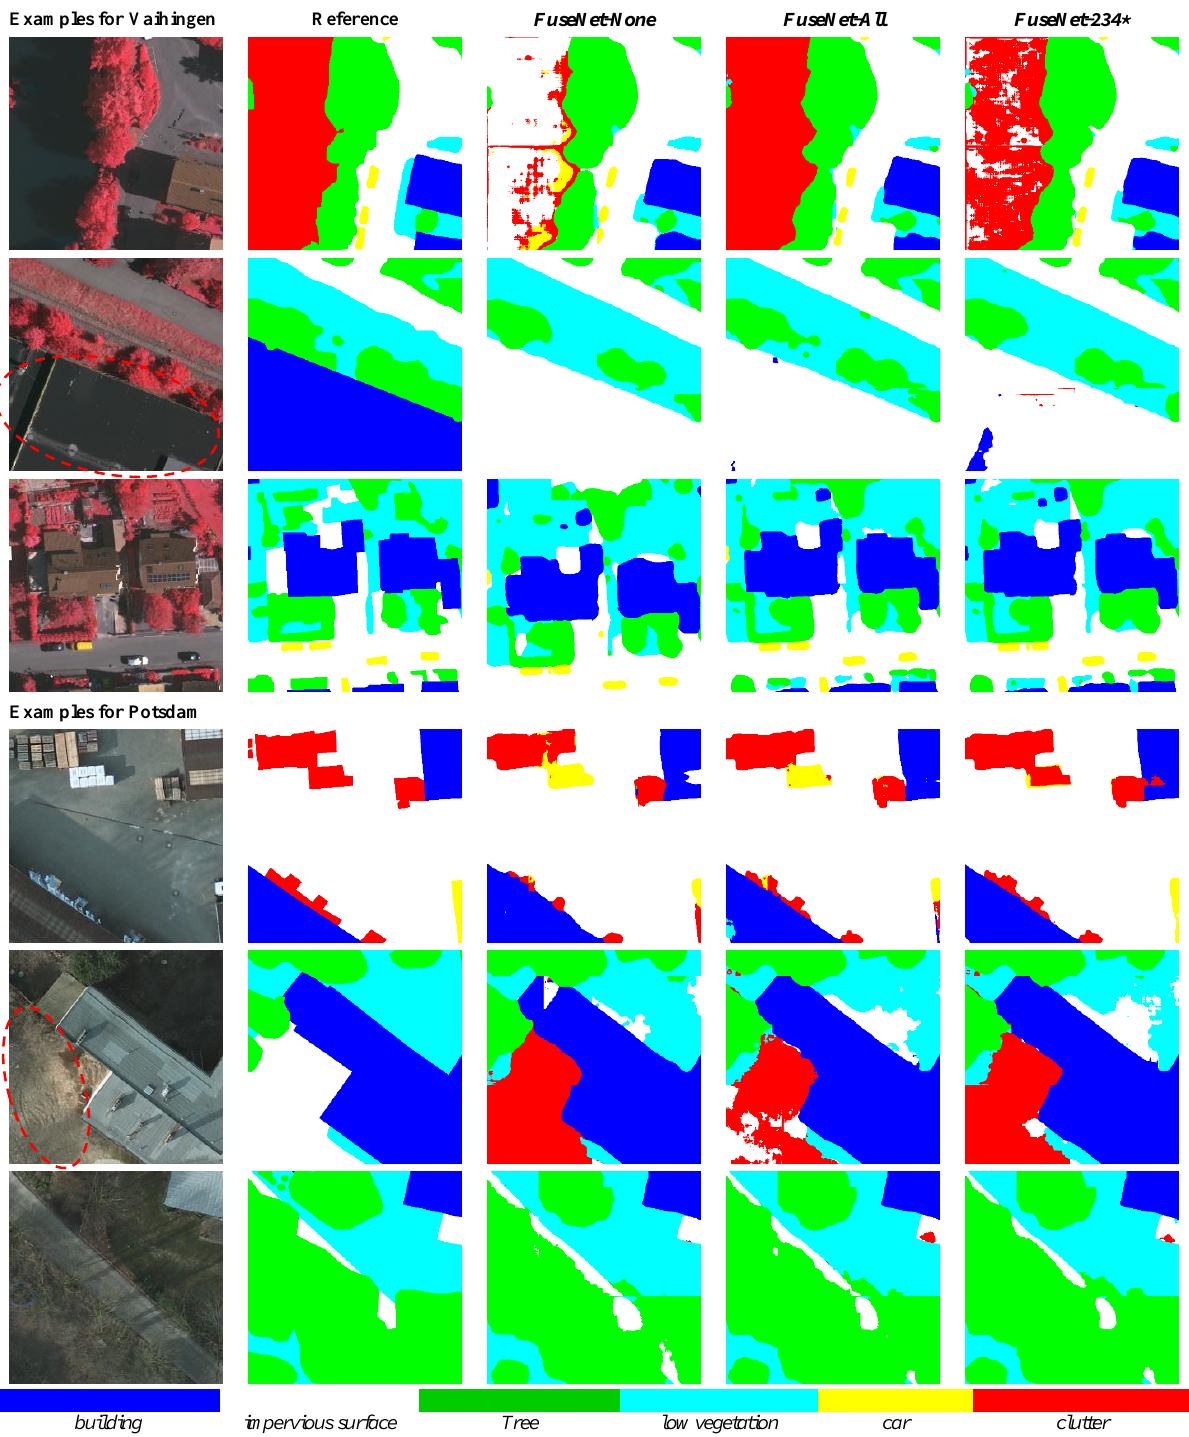
Figure 3: Data and exemplary classification results for both datasets. The first and second columns show the image and the reference, respectively; the other columns show the results for several network variants described in the main text. The colour code is given at the bottom of the figure. Red dashed ellipse: problematic areas for all network